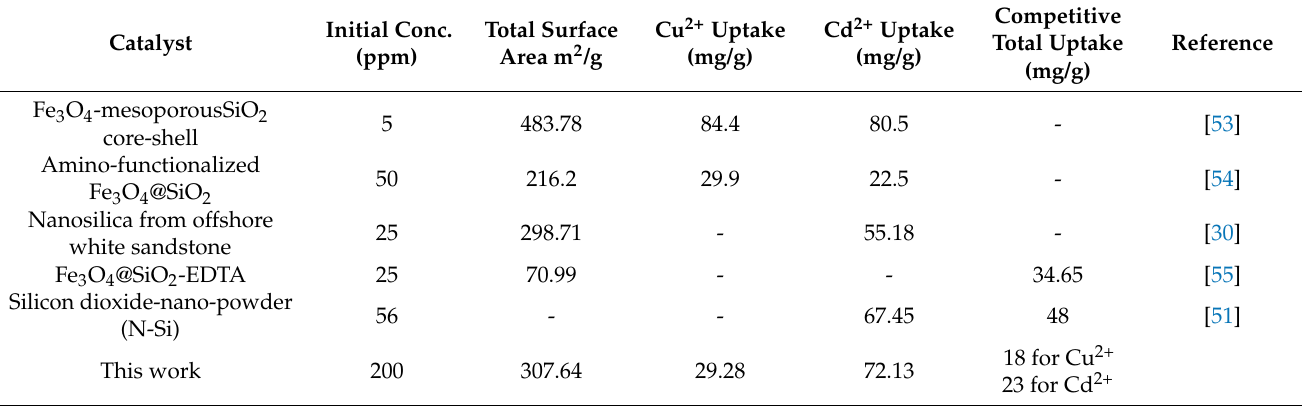
Table 3. Comparison of adsorption of Cu 2+ and Cd 2+ by various silica adsorbents.